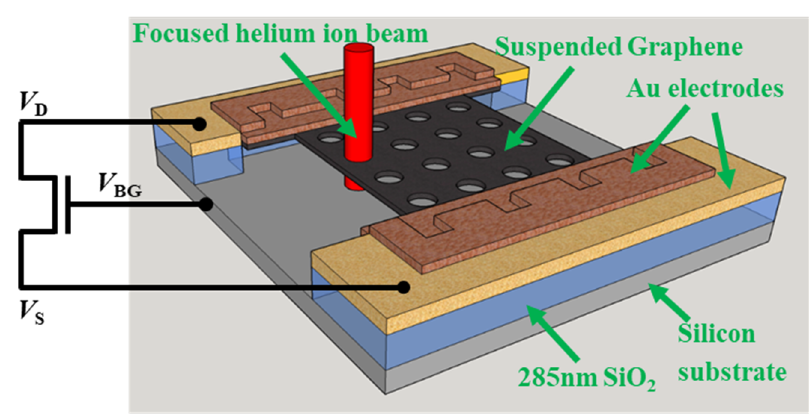
Figure 1. Schematic illustration of the 3D structure of the suspended GNM device. The Au electrodes on the two sides were used to apply drain voltage ( V D ) and source voltage ( V S ). The silicon substrate at the bottom was used to apply back gate voltage ( V BG ).